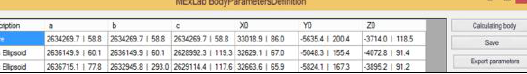
Figure 6. User interface of the module BodyParametersDefinition: determination the main axis of one of the Galilean satellite  Io.